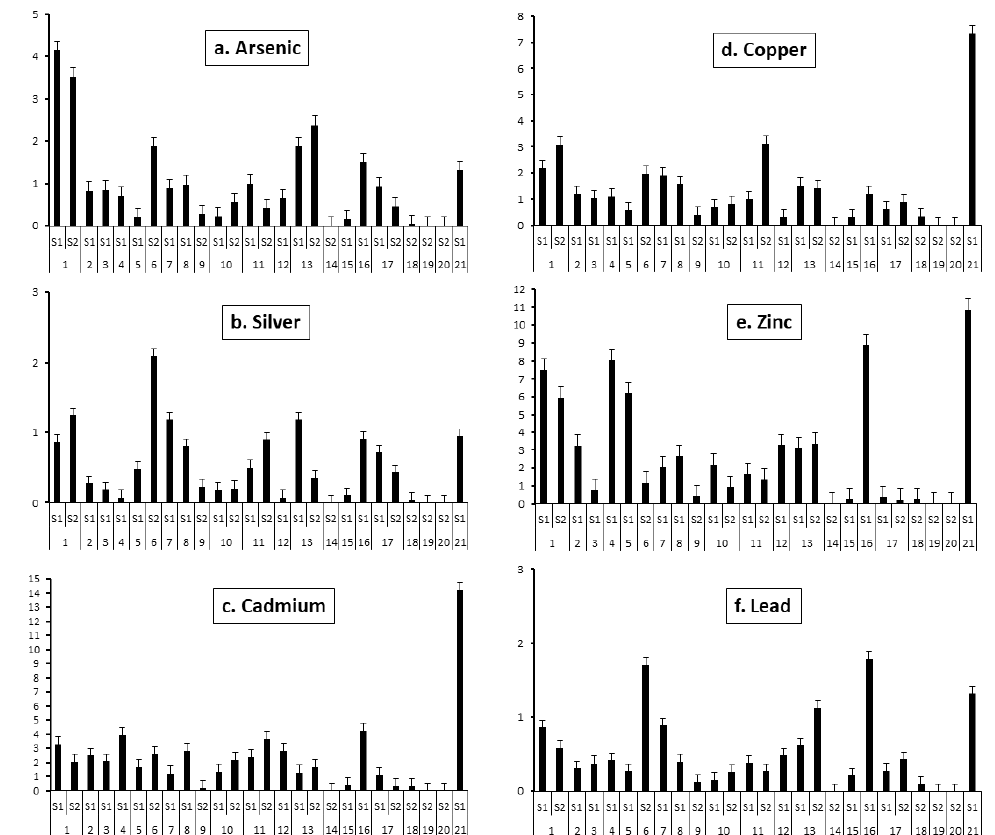
Figure 6. Translocation factor (TF) values of native species collected from two study areas (S1 and S2) in the Hualgayoc